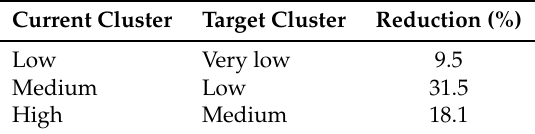
Table 9. Expected fuel-consumption reduction between contiguous